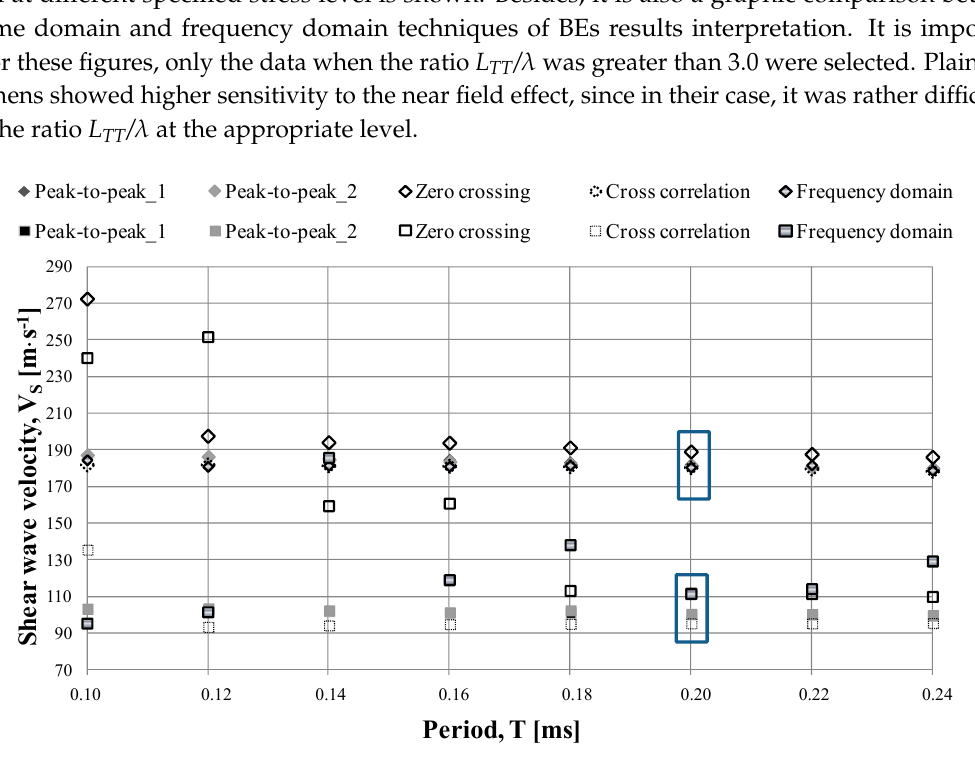
Figure 9. Variation of V S with period for p ′ = 45 kPa. Diamond symbols: pure RCA specimens; rectangle symbols: compositions of RCA with rubber chips.